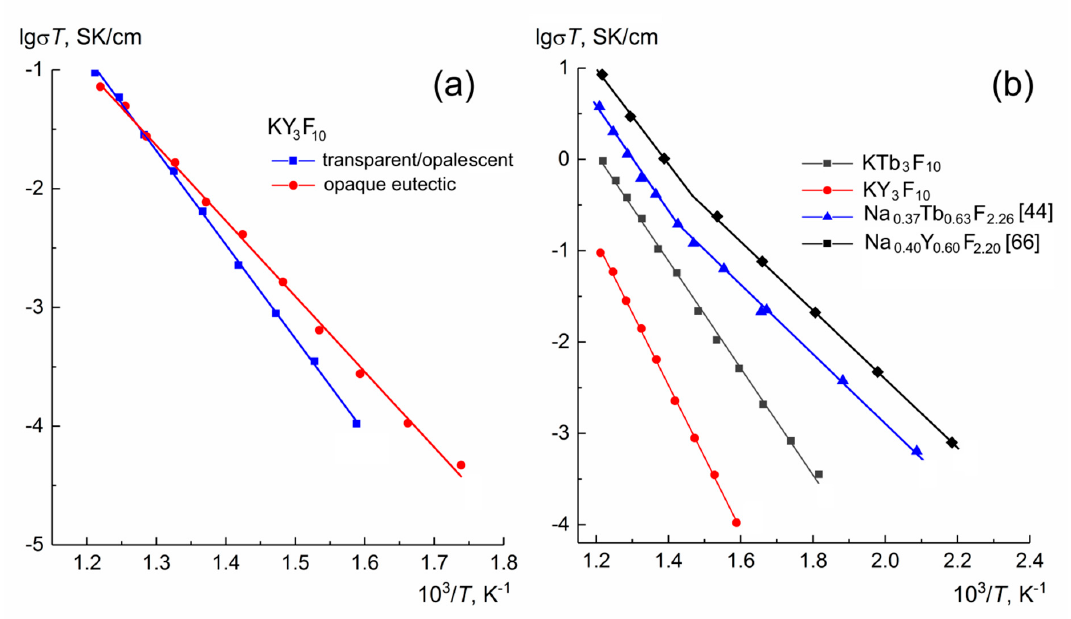
Figure 10. Temperature dependences of ionic conductivity for the samples from different KY 3 F 10 crystal fragments ( a ); comparative ionic conductivity data for KF- and NaF-based single crystals ( b